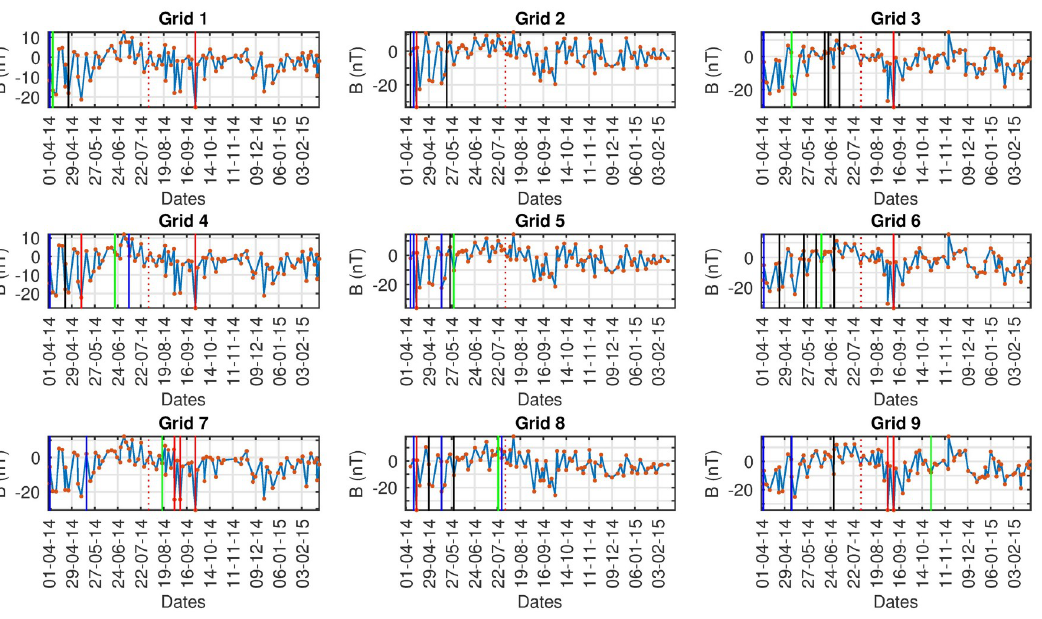
PLOS ONE | https://doi.org/10.1371/journal.pone.0212098 April 29,